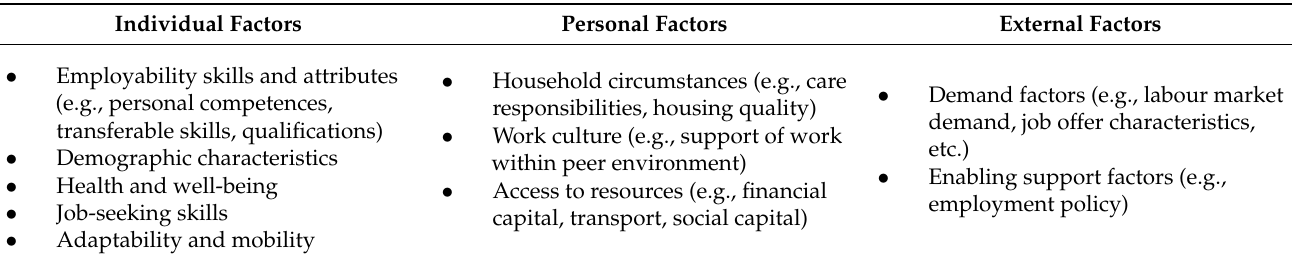
Table 1. Broad model of employability, adapted from